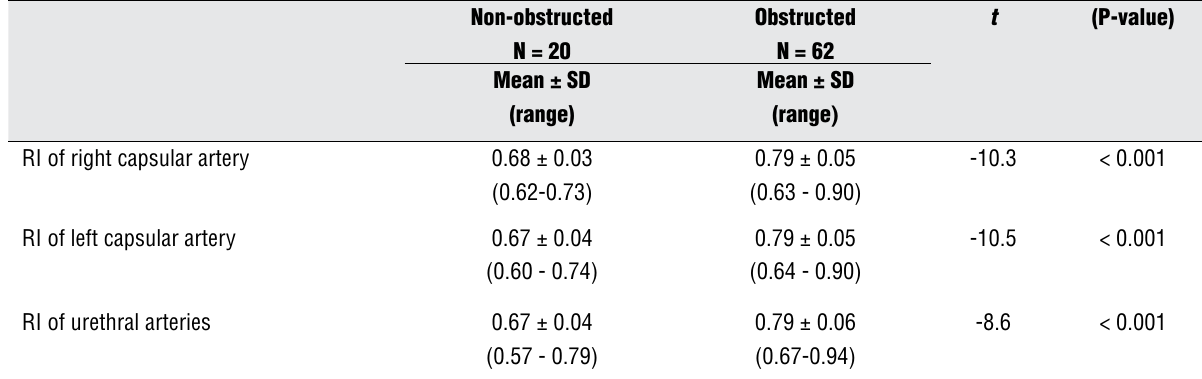
Table 2 - Comparison of RI of Rt. & Lt. capsular and urethral arteries between obstructed and non-obstructed groups of patients (according to